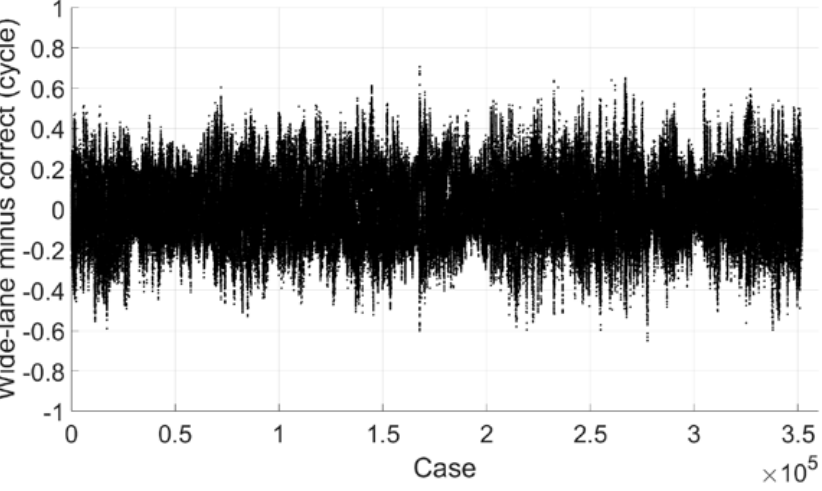
Figure 13. Wide-lane ambiguity minus correct integer ambiguity (Galileo).